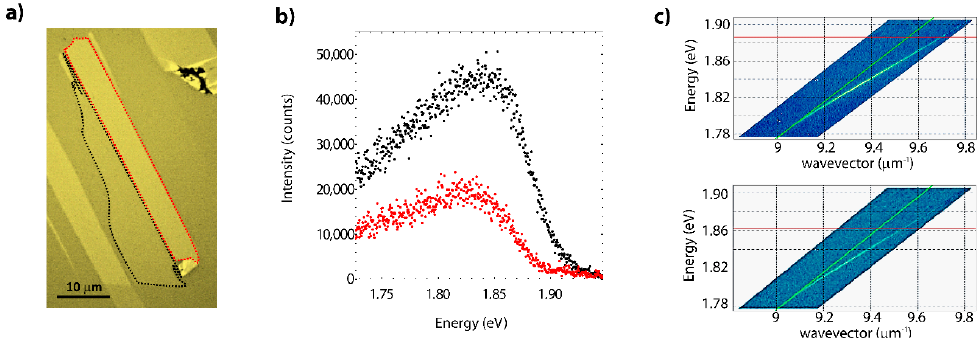
Figure 2. ( a ) Reflection space map (from the top side of the DBR) revealing the mono (delimited by black dashed line) and bilayer (delimited by red dashed line) of MoS 2 . ( b ) Emission signals of mono (black dots) and bilayer (red dots) detected from the top of the DBR. ( c ) Monolayer (upper pannel) and bilayer (lower panel) dispersion emission coupled to the BSW (i.e., detected from the prism side and across the total internal reflection regime). The green line defines the lightline dispersion, and the red line the excitonic absortion peak energy.